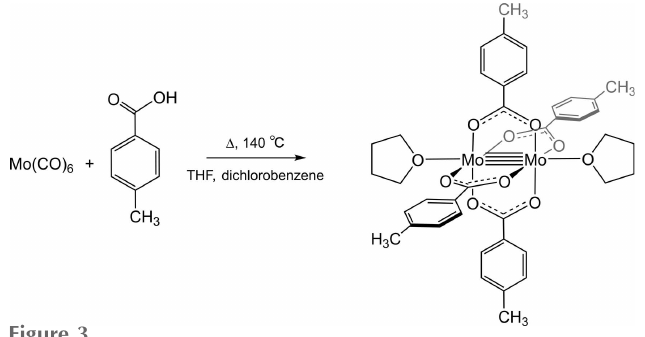
Figure 3 Synthesis scheme for [Mo 2 ( p -O 2 CC 6 H 4 CH 3 ) 4 (C 4 H 8 O) 2